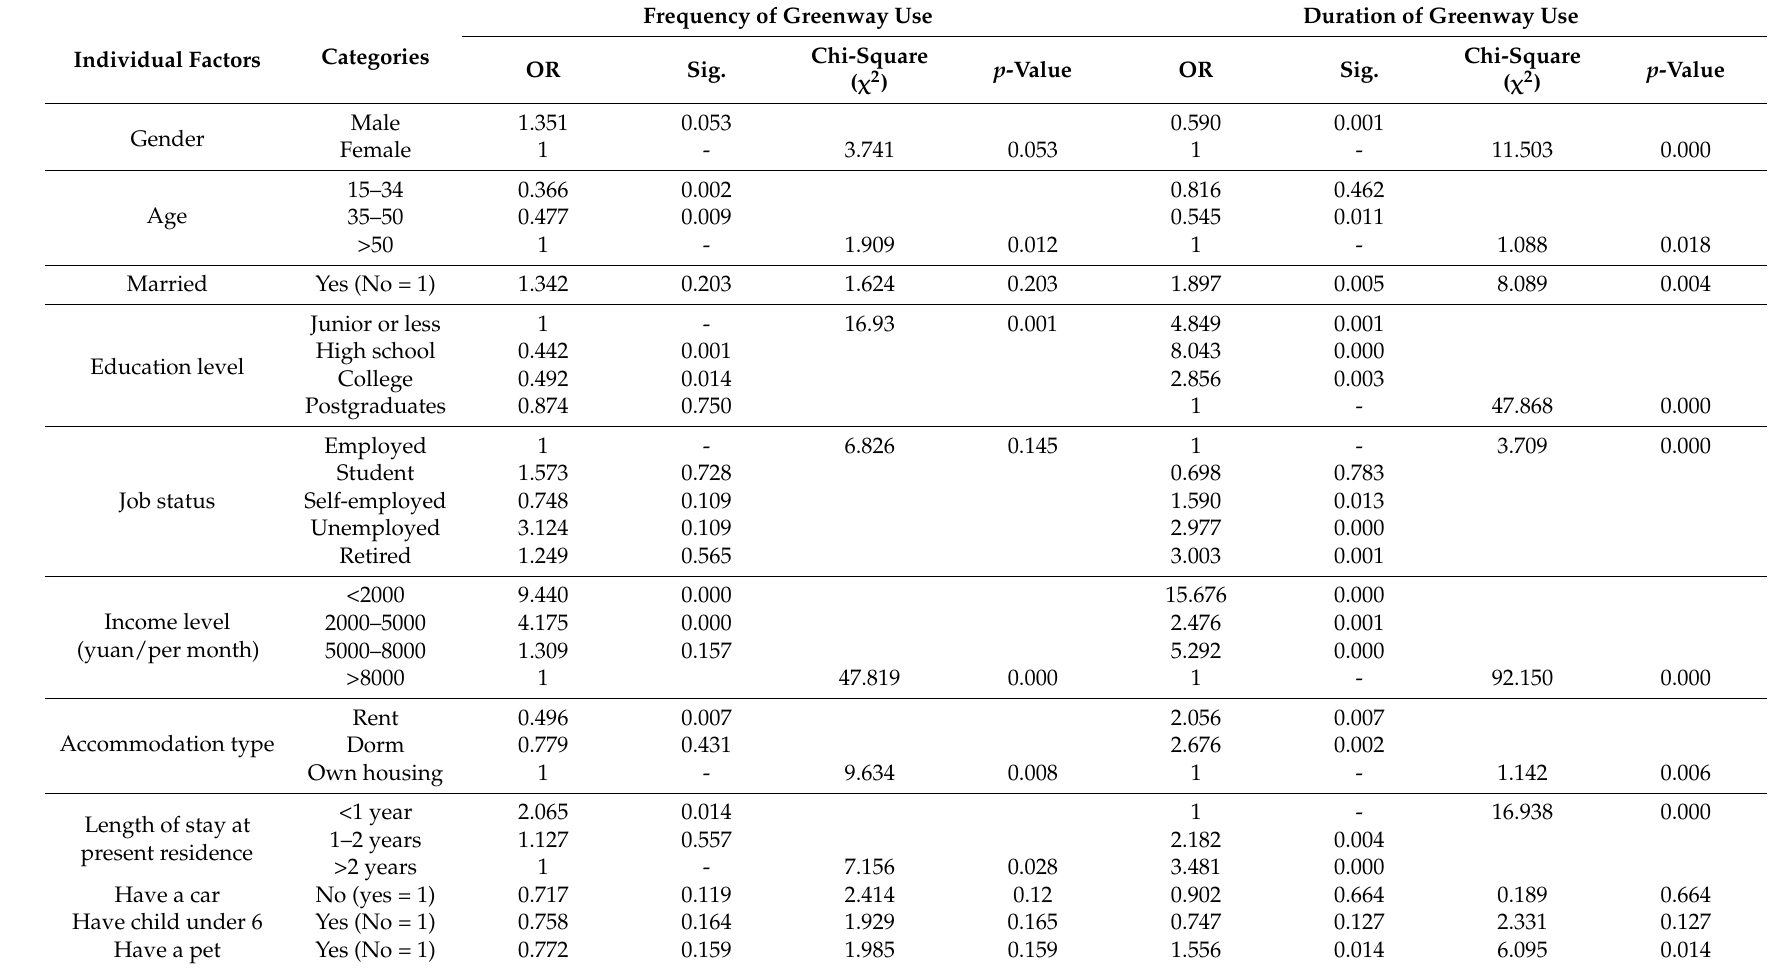
Table 4. Odds ratio for potential factors influencing greenway